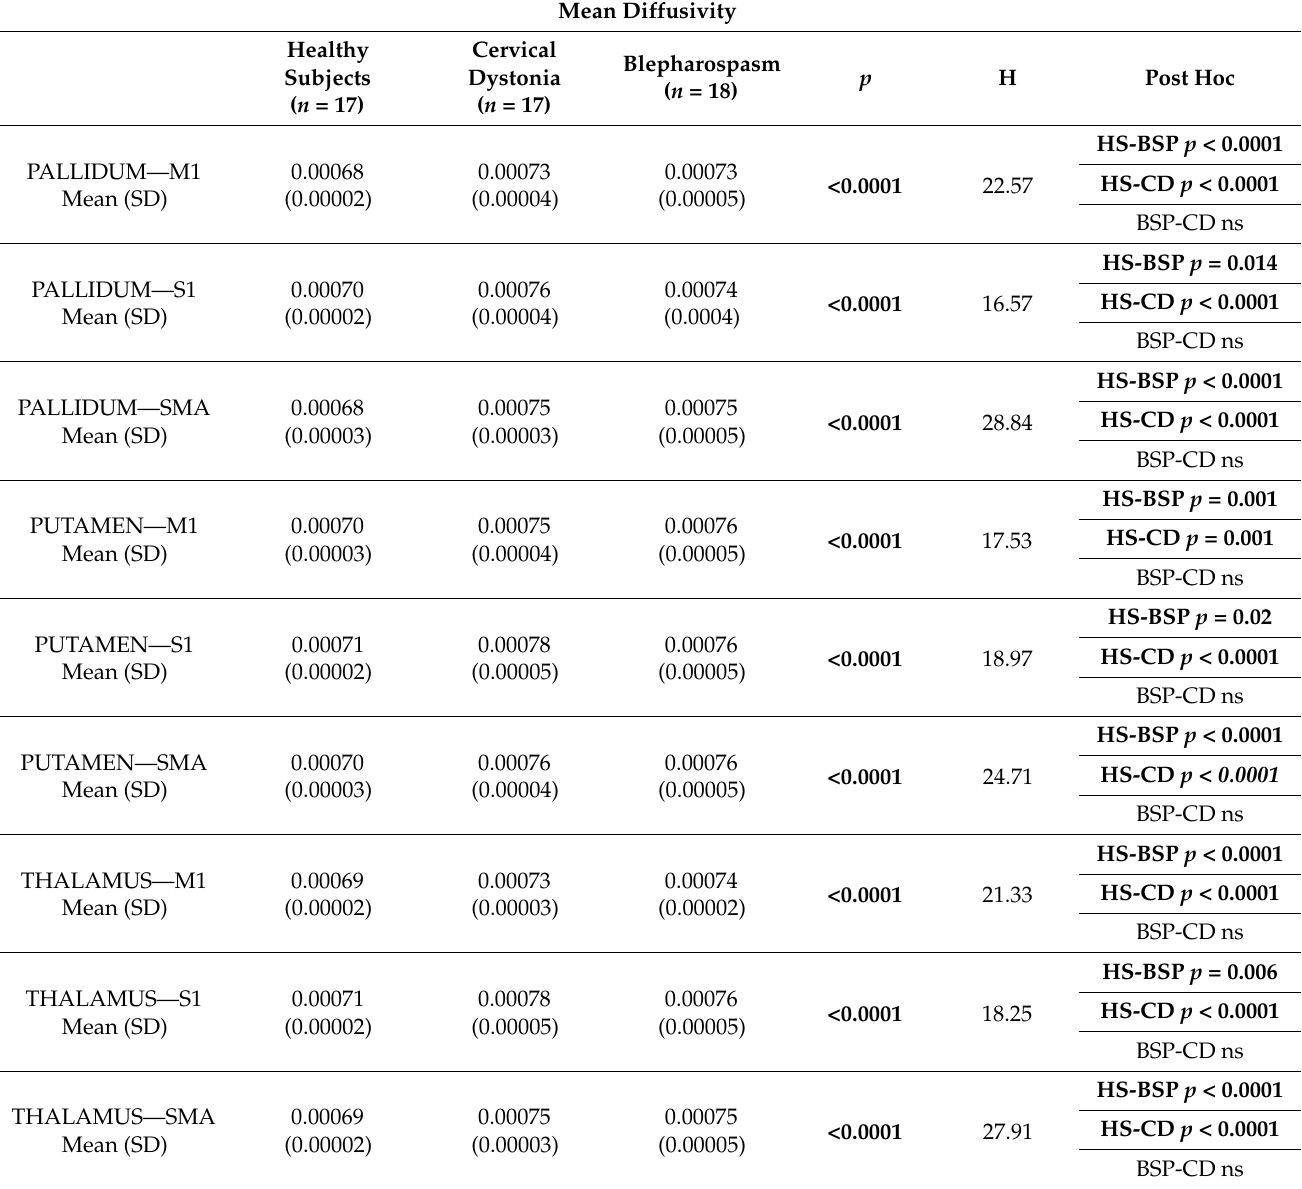
Table 3. Mean diffusivity of subcortical-cortical WM